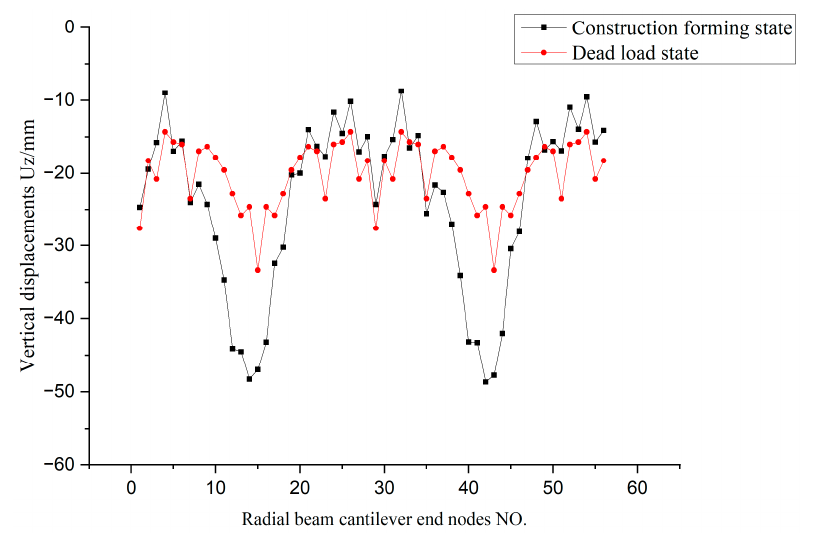
Figure 56. Comparison curve of vertical deformation of cantilever ends in two states